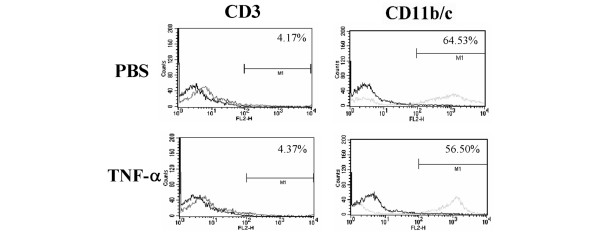
The composition of peritoneal lavage cells of tumour necrosis factor (TNF)α-treated Lewis (LEW) rats was comparable to that of phosphate-buffered saline (PBS)-treated rats. LEW rats (n = 4) were injected intraperitoneally daily with 1 ml of PBS (top panel) or TNFα (105 U) (bottom panel) for 4 days. After 3 h post the fourth injection, the peritoneal cavity was flushed with PBS and 10 ml of the peritoneal lavage fluid was collected. The cells harvested from the lavage fluid were stained with appropriately labelled anti-CD3 or anti-CD11b/c antibody and analysed by fluorescence-activated cell sorting (FACS). The results of one of the two independent experiments are shown in the figure. Both experiments yielded similar results.